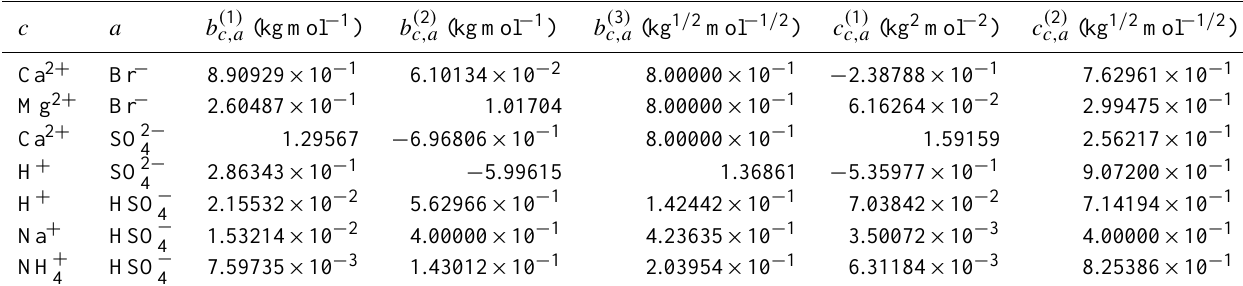
Table 5. Fitted binary cation ↔ anion middle-range interaction parameters of new and revised aqueous electrolyte